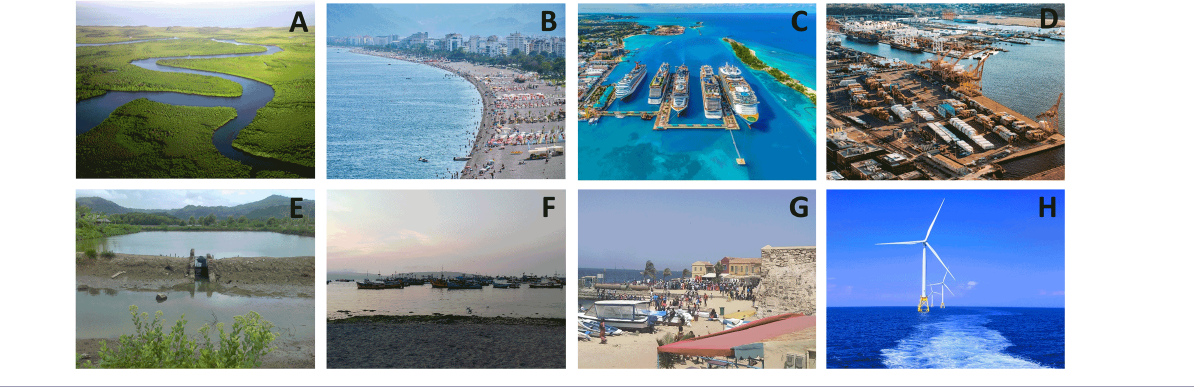
Fig. 1 . Diverse coastal systems and uses. (A) A large wetland and river on the coast of The Gambia. (B) A coastal beach populated by tourists in Turkey. (C) Large port development for tourism in the Caribbean. (D) Port development for industry and trade in Japan. (E) Wetland pond aquaculture system in an Indonesian mangrove forest with water supplied by tidal flows. (F) Small-scale fishing boats off the coast of Peru. (G) A Senegalese fishing village. (H) Offshore wind energy in the United States. Photos A, B, C, D, H received from https://unsplash.com/. Photos E, F, G taken by the